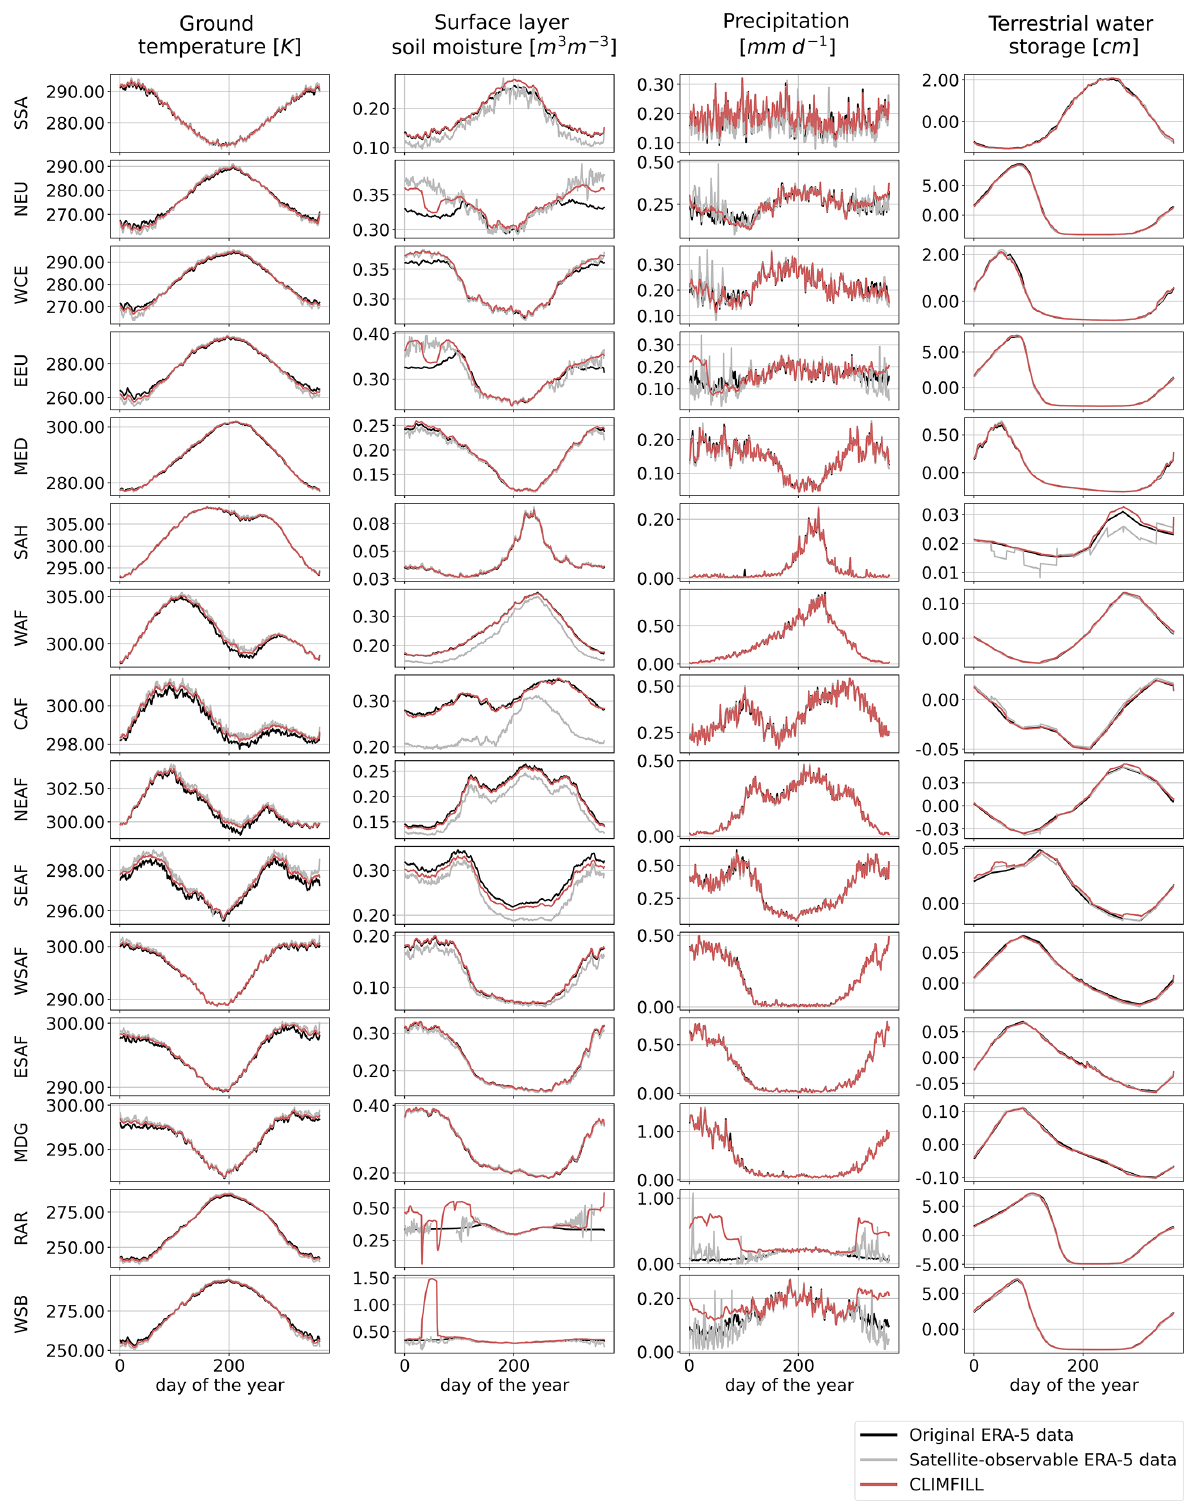
Figure A3. Figure A2